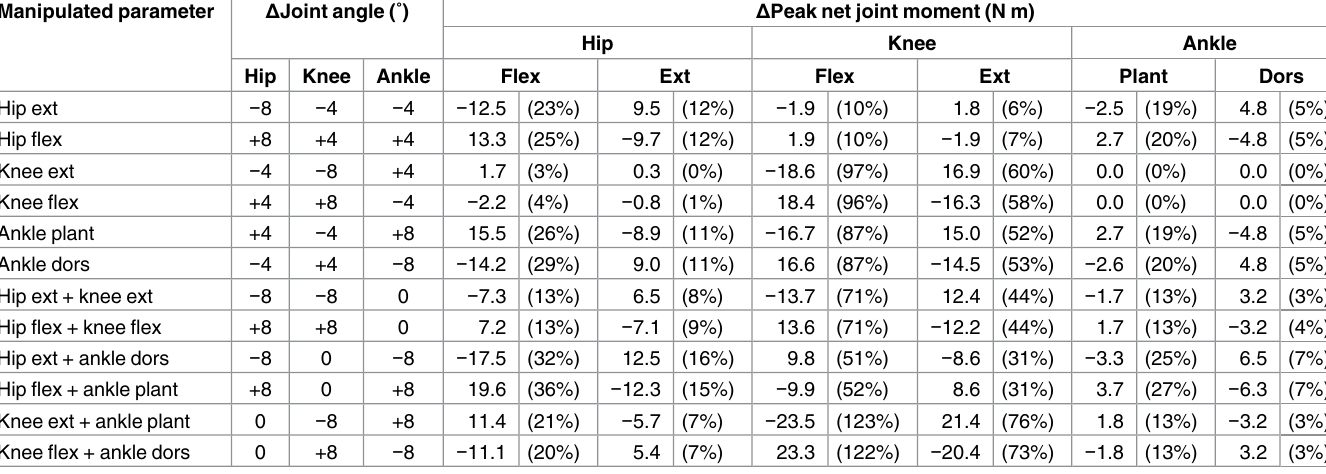
Table 3. Effect of 2 SD change of joint angles on peak net moments at the hip, knee and ankle evaluated as a change from the original value in N m and percentages. Manipulated parameter